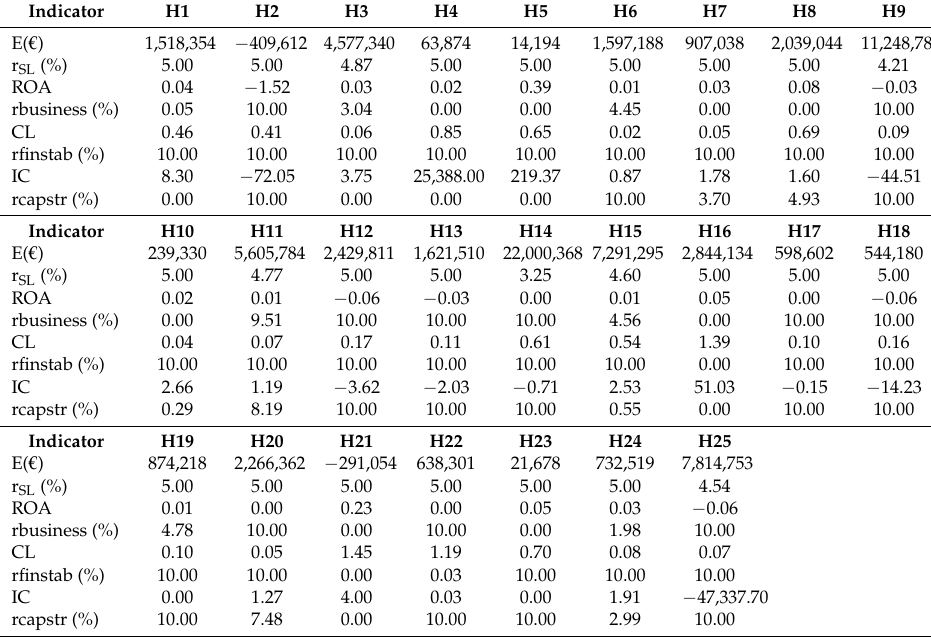
Table 5. Results of selected internal